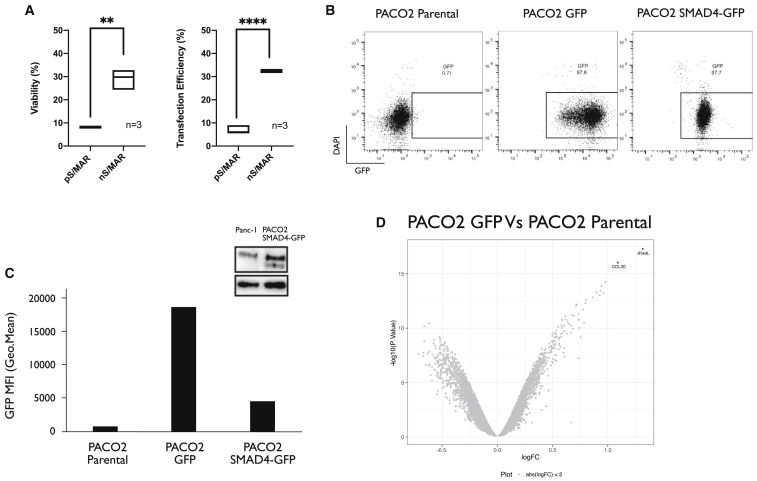
Genetic Modification of Primary Pancreatic Tumor Cells (PACO2) Using nS/MAR DNA Vector TechnologypS/MAR and nS/MAR vectors expressing the reporter gene GFP were transferred into PACO2 cells through electroporation. (A) The viability and the efficiency (number of viable GFP+ cells) of transfection were evaluated by flow cytometry and are represented as boxplots, where the line represents the median (n = 3, analyzed by t test; viability, p = 0.0012; transfection efficiency, p < 0.0001). (B) PACO2 primary pancreatic cancer cells were established with nS/MAR-GFP and n/MAR-SMAD4-GFP (nS/MAR-SMAD4). (C) The expression of the reporter gene GFP was evaluated in flow cytometry in comparison to parental unmodified PACO2 cells. Western blot analysis shows successful re-introduction of SMAD4 in nS/MAR-SMAD4 PACO2 cells. SMAD4 wild-type (WT) Panc-1 cells are shown as a control. (D) Volcano plot showing the gene expression changes of PACO2 GFP versus parental cells. Highlighted in red are genes with a fold change of 2 and p < 0.05.